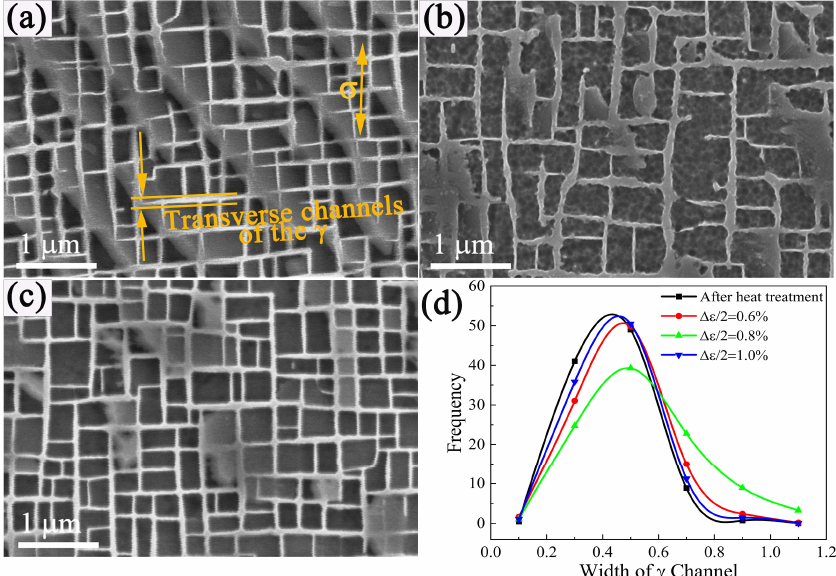
Figure 6. Transmission electron microscope (TEM) bright field (BF) images showing dislocation con- figurations of an alloy at 980 °C under Δ ε t /2 = 0.6%: ( a ) distribution of the dislocations; ( b ) bowing Figure 5. Microstructures of the longitudinal profile: ( a ) Δ ε t /2 = 0.6%, ( b ) Δ ε t /2 = 0.8%, and ( c ) Δ ε t /2 Figure 5. Microstructures of the longitudinal profile: ( a ) ∆ ε t /2 = 0.6%, ( b ) ∆ ε t /2 = 0.8%, and and tangled dislocations; and ( c ) formation of dislocation networks. = 1.0%. ( d ) Width of the transverse channels of the γ phase. ( c ) ∆ ε t /2 = 1.0%. ( d ) Width of the transverse channels of the γ phase.